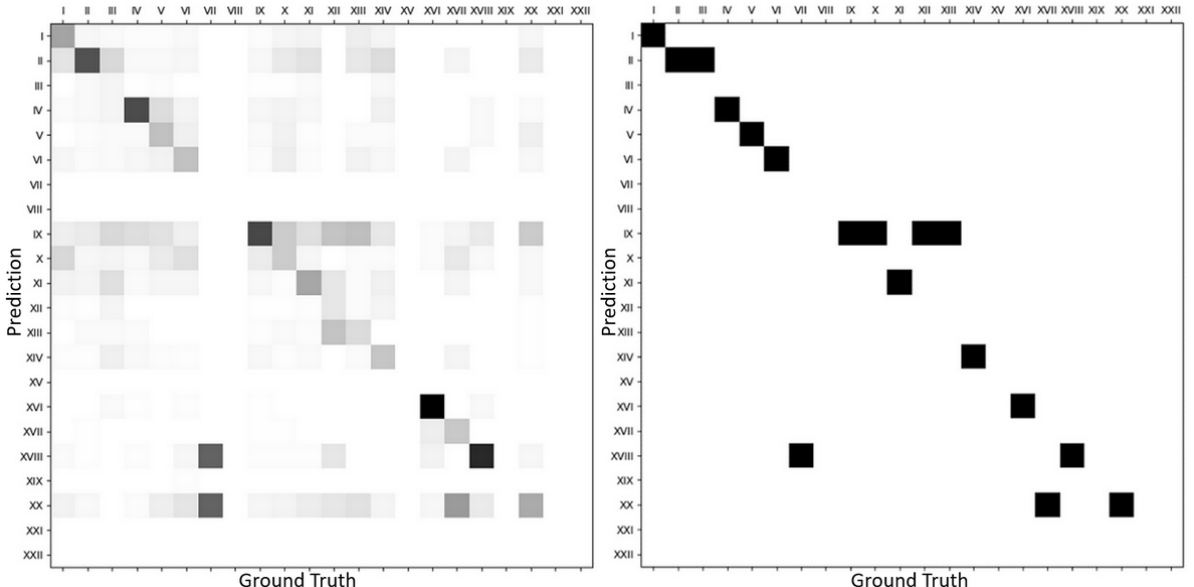
Figure 6. The left-hand plot shows the distribution of wrong predictions per ICD-10 chapter versus their ground truth (the lighter the rarer). The right-hand plot shows the same distribution’s modes. Apparent missing values in both plots correspond to chapters either not represented in the test dataset or on which no mistakes were made. ICD-10: 10th revision of the International Statistical Classification of Diseases and Related Health